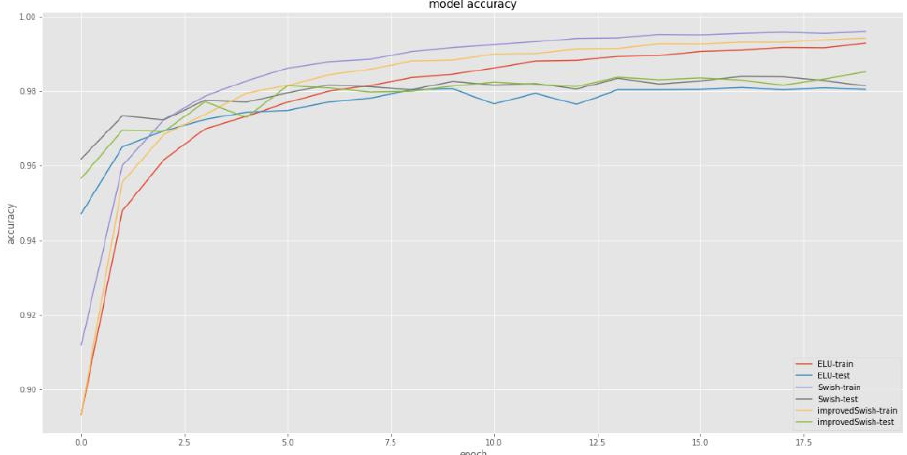
Figure 4. Comparison of accuracy. The horizontal axis represents epoch times (0~17.5), and the vertical axis represents accuracy value (0.8~1).